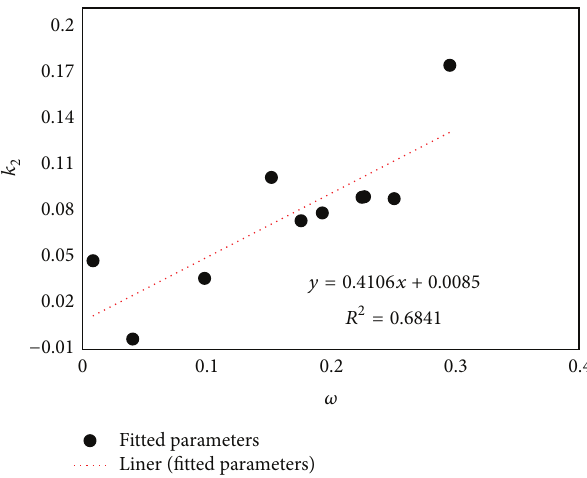
Figure 2: Linear trend of fitted parameter 𝑘 2 of the 𝛼 -function equation